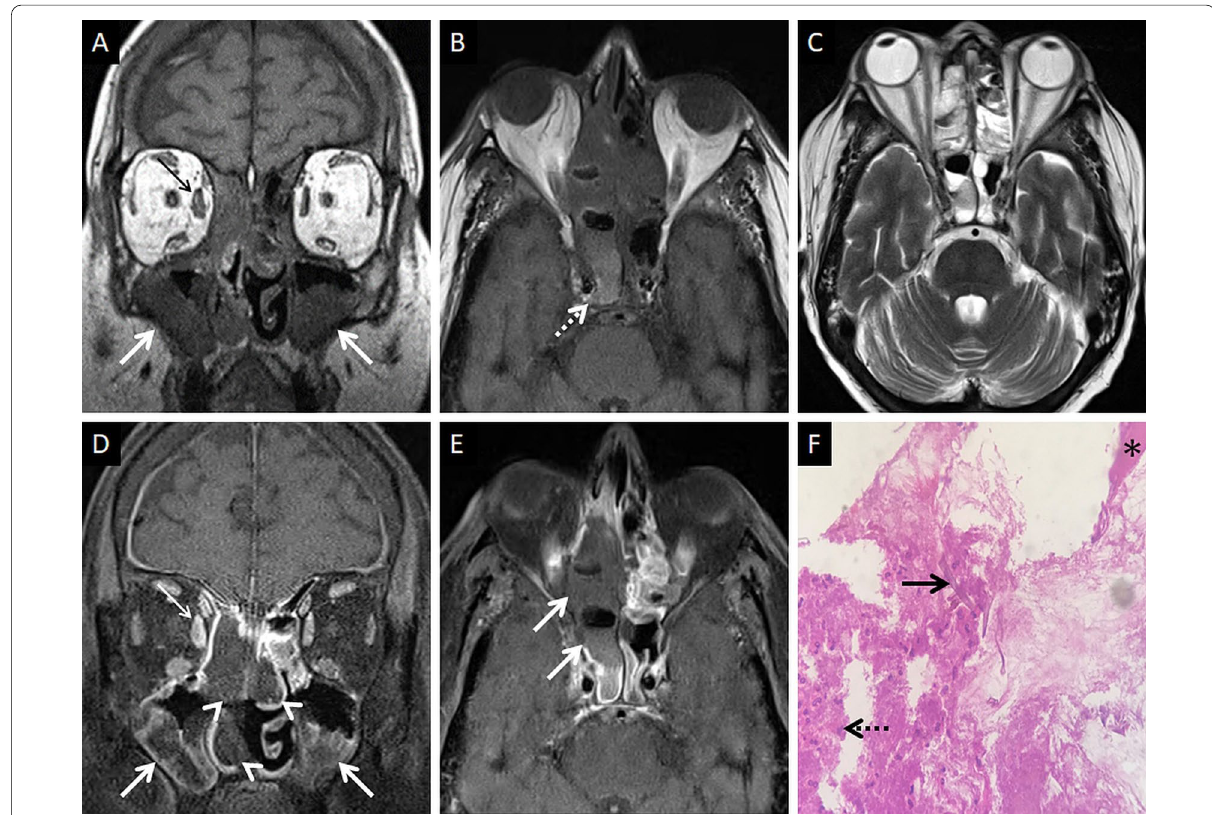
Fig. 6 Sinonasal involvement of ROCM. Unenhanced coronal T1W image ( a ) reveals diffuse, intermediate signal intensity, mucosal and mucoperiosteal thickening (thick arrows) in the nasal cavities and the maxillary sinuses, respectively. Note the slight asymmetric thickening of the right medial rectus muscle (thin arrow). Unenhanced axial T1W image ( b ) reveals mucoperiosteal thickening in the ethmoid and sphenoid sinuses with mild T1 shortening in the right sphenoid sinus (dotted arrow), consistent with fungal paramagnetic content. Axial T2W image ( c ) reveals non-specific, mixed signal intensity signals within the ethmoid and sphenoid sinuses. CE FS coronal T1W image ( d ) shows lack of enhancement in both middle turbinates and the right inferior turbinate (black turbinate sign—arrow heads), along with non-enhancing mucoperiosteal thickening in the maxillary sinuses (thick arrow). Note the asymmetric enhancement of the right medial rectus muscle (thin arrow) suggesting myositis. CE FS axial T1W image ( e ) confirms poor enhancement of the right ethmoid and sphenoid sinus mucoperiosteal thickening (thick arrows). Post-operative histopathology analysis ( f ), using HE staining, demonstrates shows few branching, aseptate fungal hyphae (thick arrow) consistent with the diagnosis of MCR along with neutrophilic and histiocytic inflammatory infiltrates (dotted arrow) and necrotic tissues